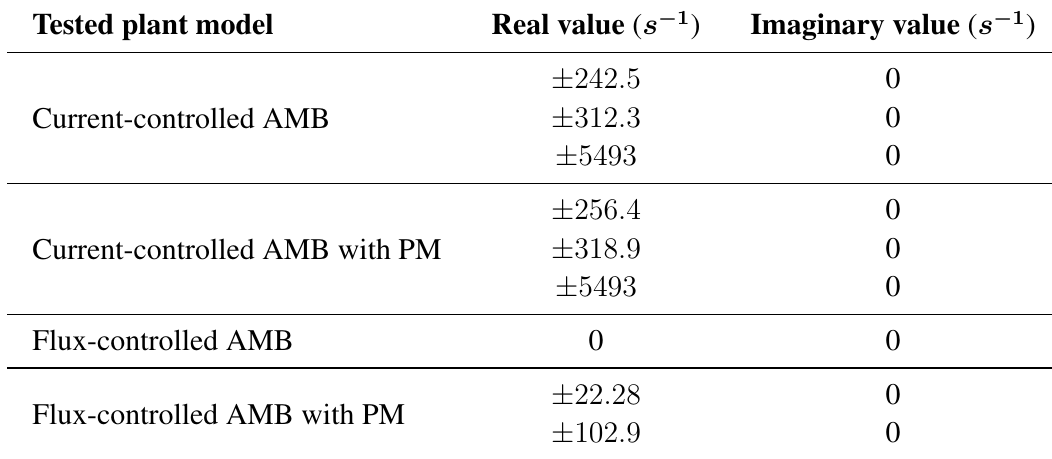
Table 1. Eigenvalues of the open-loop